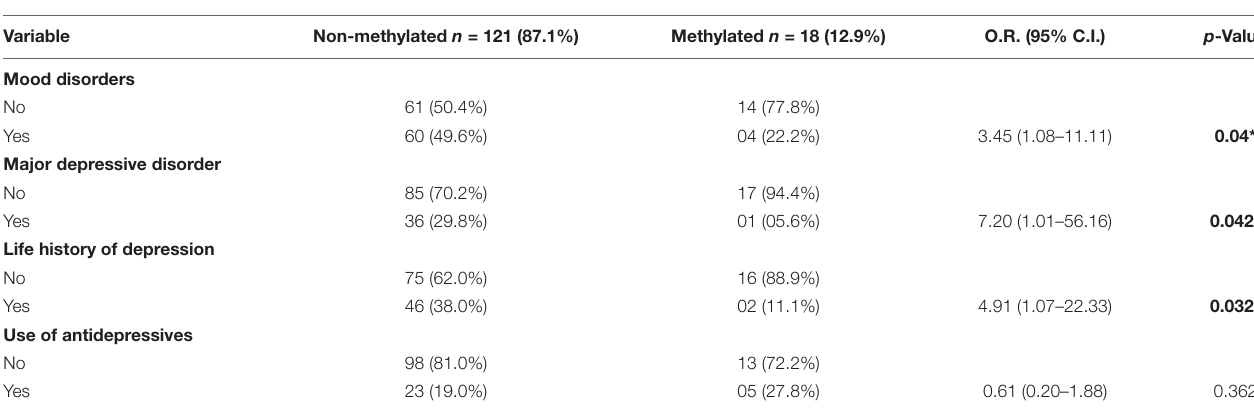
TABLE 4 | Mood disorder and antidepressive use according with